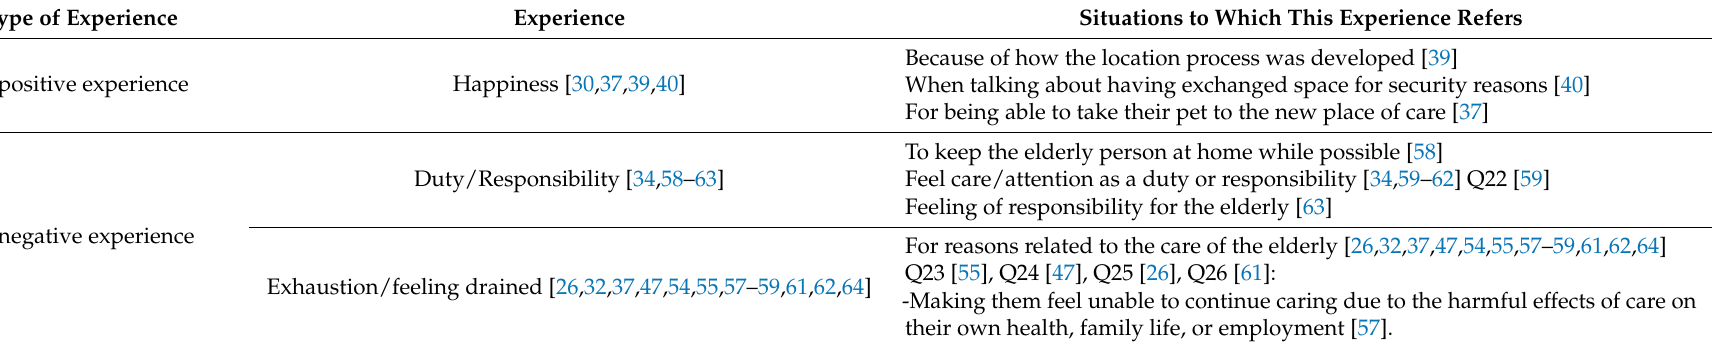
Table 5. Unique relevant experiences by population group a